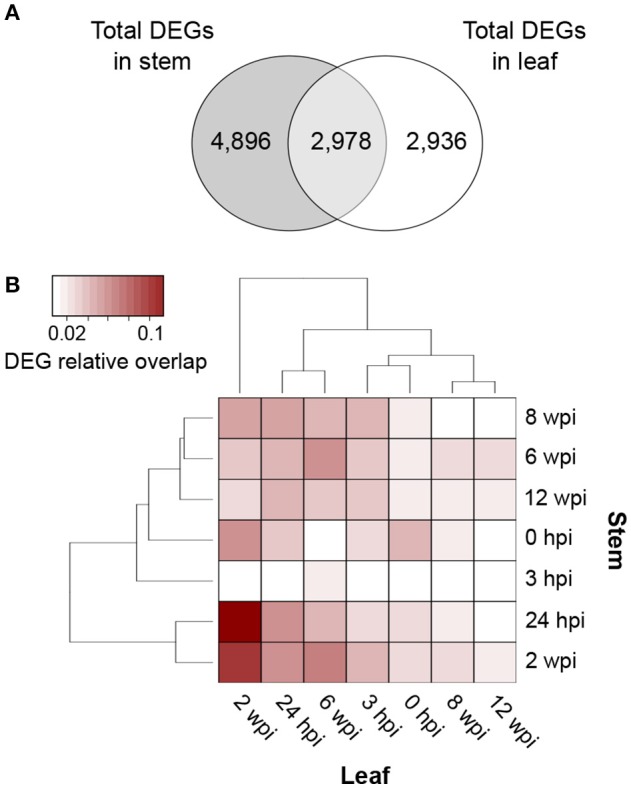
Comparisons of differentially expressed genes (DEGs) in response to N. parvum infection. (A) Venn diagram displaying common and unique DEGs (adjusted P ≤ 0.05) when comparing responses to N. parvum colonization in stem and leaf tissues. (B) Heatmap of the relative DEG overlap between stem and leaf tissues during N. parvum infection.